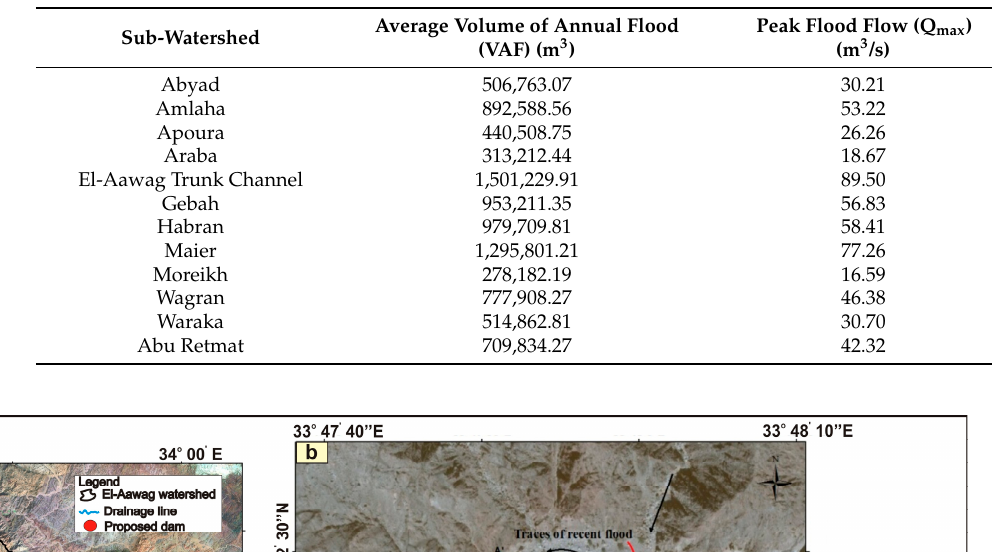
Table 4. The annual flood volume of W. El-Aawag sub-watersheds.